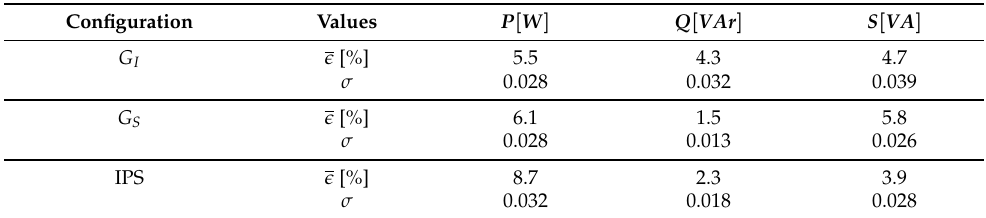
Table 5. Mean error and standard deviation between values obtained in simulation and